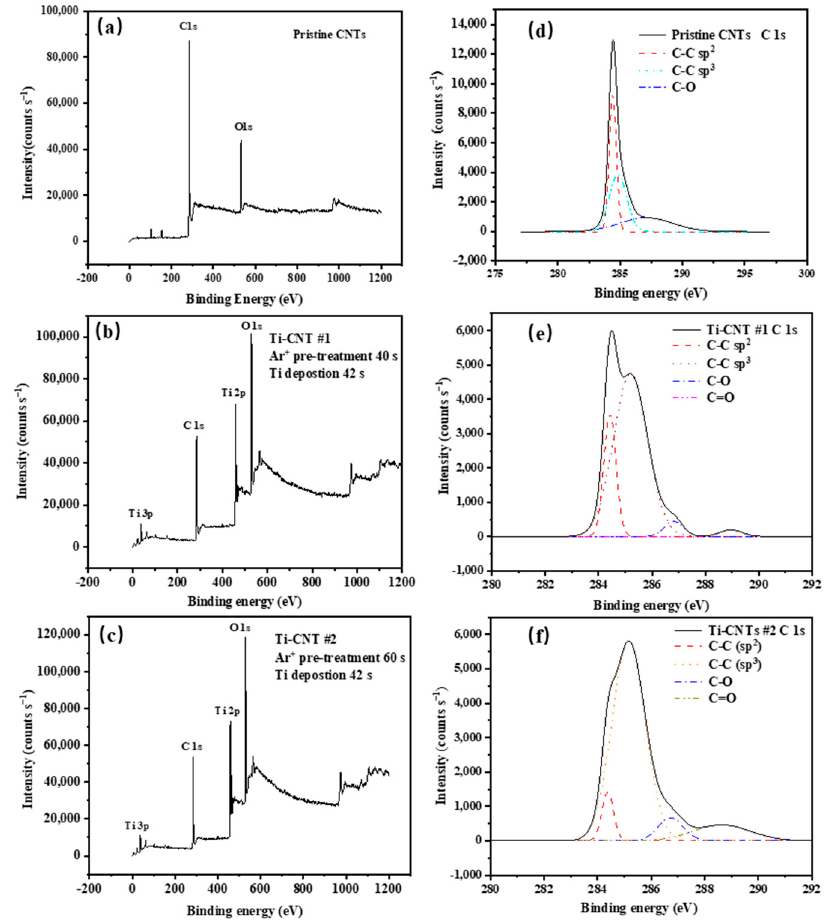
Figure 3. The XPS spectra of different CNT samples: ( a ) pristine CNTs, ( b ) Ti-CNTs #1, ( c ) Ti-CNTs#2, ( d ) C 1 s states of Pristine CNTs, ( e ) C 1 s states of Ti-CNTs #1, ( f ) C 1 s states of Ti-CNTs#2.